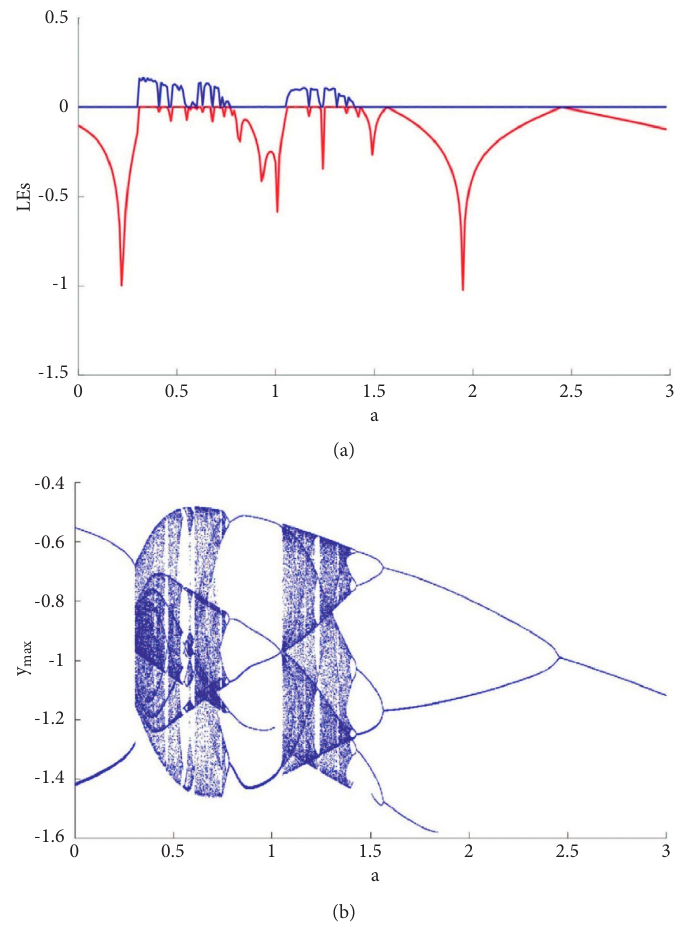
Figure 2: Lyapunov exponents and bifurcation diagrams for different a values. (a) The systems’ two larger Lyapunov exponents are plotted. Periodic behaviors (one Lyapunov exponent negative and one zero), torus behaviors (when both Lyapunov exponents are zero), and chaotic behavior (one Lyapunov exponent is zero and another one is positive) can be seen in the diagram. (b) The bifurcation diagram of the system is plotted when the period-doubling route to chaos (from right to left) and period windows can be observed in the